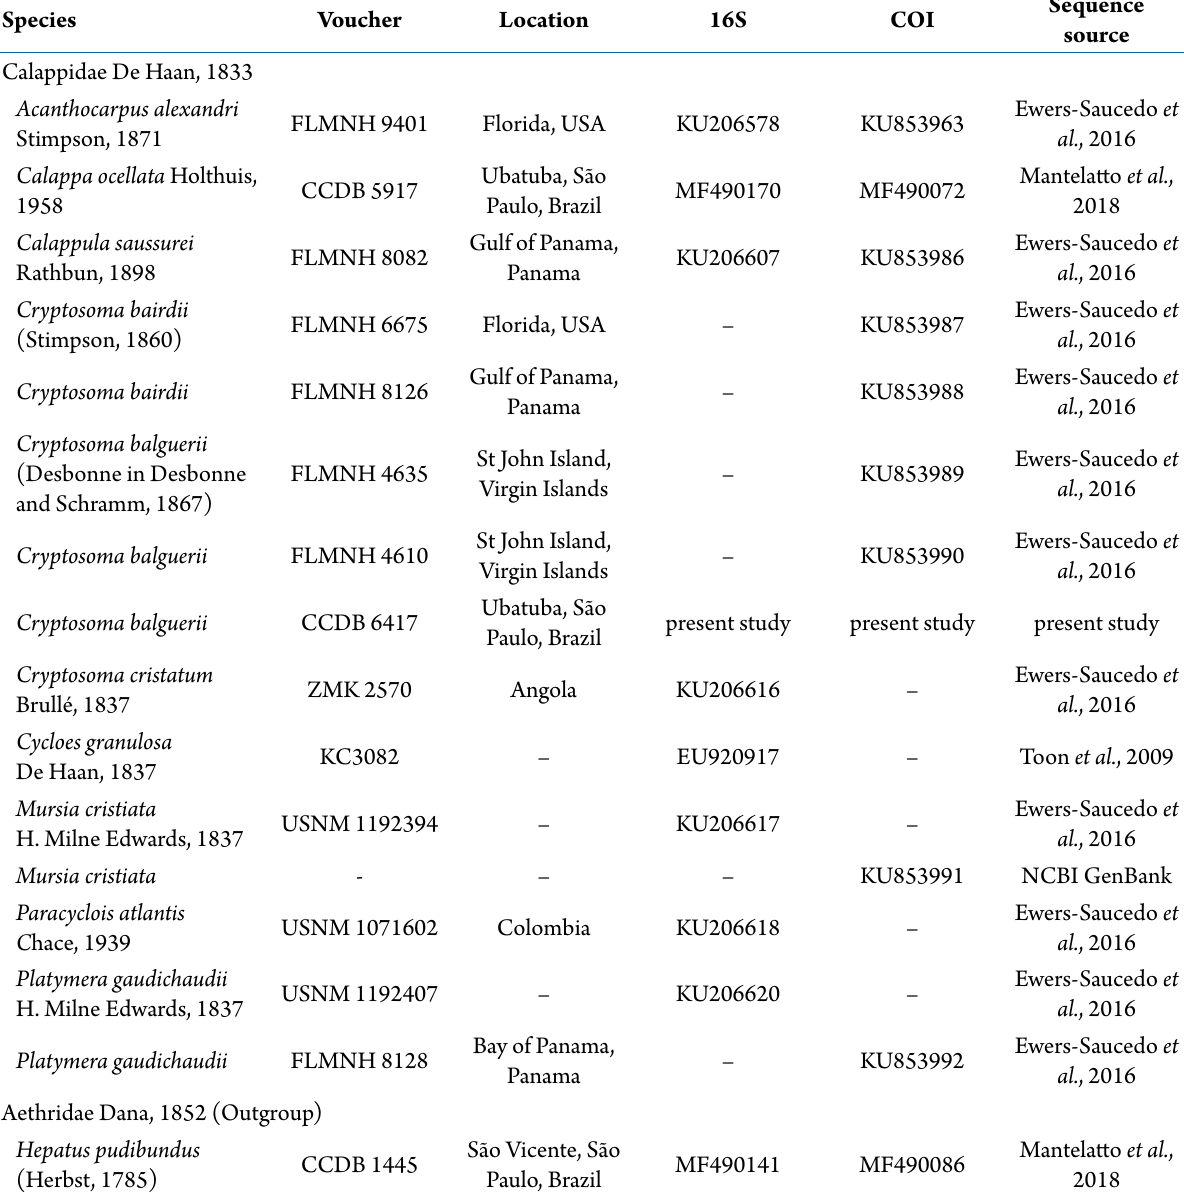
Table 1. Collection details for Cryptosoma balguerii (Desbonne in Desbonne and Schramm, 1867) and species of Calappidae De Haan, 1833 used in the present study. Voucher refers to specimen and respective catalog numbers from museum collections. Location refers to the region of collection of the specimen. 16S and COI refer to the DNA fragments and respective numbers of NCBI Genbank accession. Abbreviations: CCDB = Coleção de Crustáceos do Departamento de Biologia da Faculdade de Filosofia, Ciências e